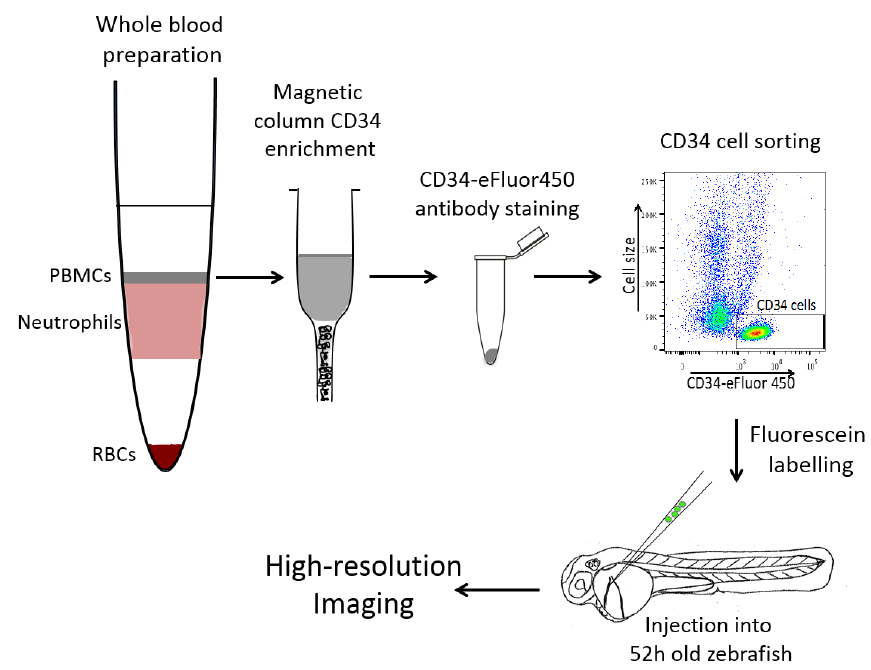
Figure 1. Diagram of our protocol: How to purify human CD34 cells from whole blood and transplant into zebrafish. Whole blood preparation by Percoll gradient allowed us to separate peripheral blood mononuclear cells (PBMCs) from neutrophils and red blood cells (RBCs). PBMCs were enriched for CD34 cells using a positive selection magnetic column. A pure CD34 cell population was sorted using a human anti-CD34eFLuor450 antibody by FACS. CD34 cells were labelled using fluorescein and injected into the Duct of Cuvier of 52 hour post fertilisation zebrafish larvae. Animal with human cells in their CHT were selected for further high-resolution